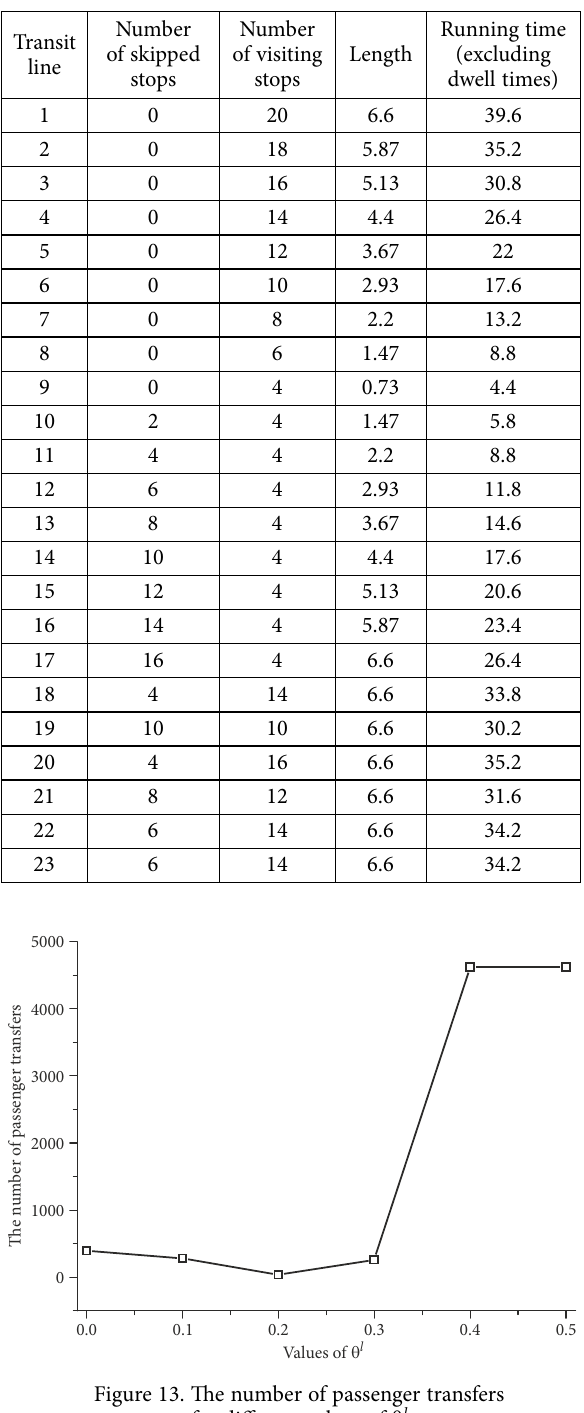
Table 5. Characteristics of feasible